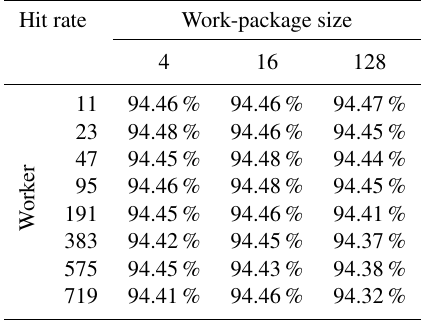
Table 5. Hit rate after 200 iterations on SimDolKtz